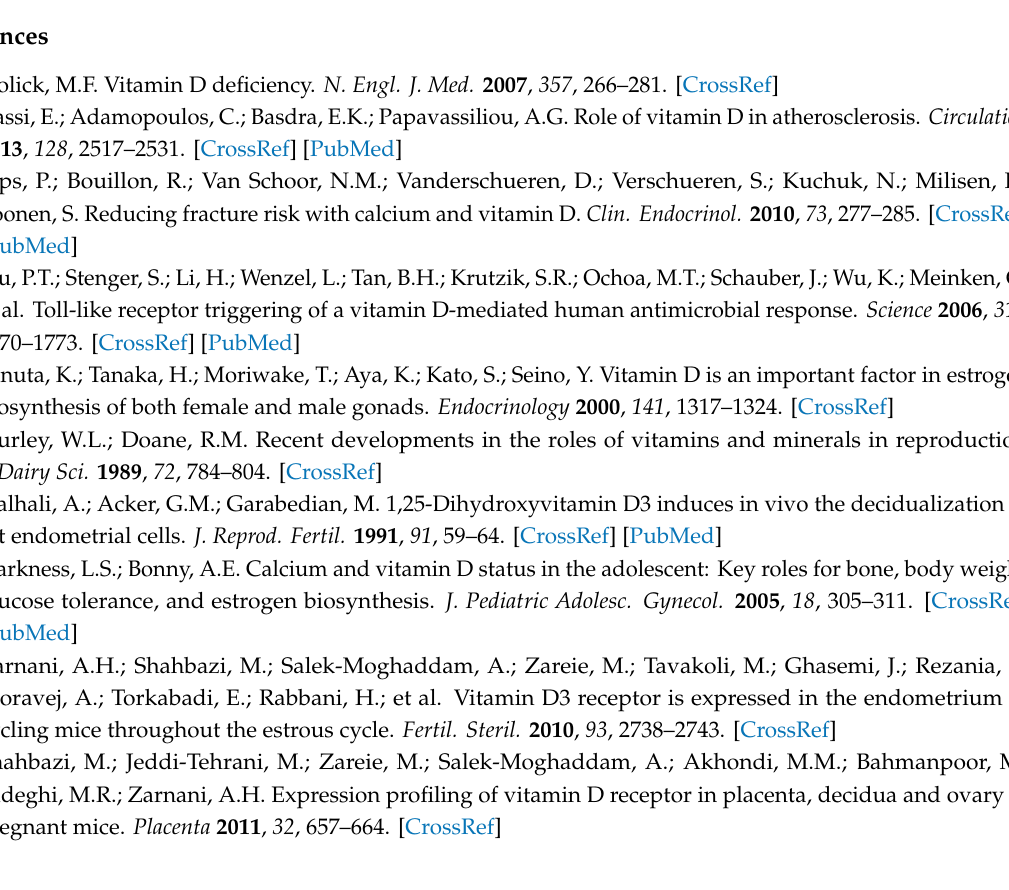
Table S1: Newcastle-Ottawa Scale (NOS) for assessing quality of interventional cohort